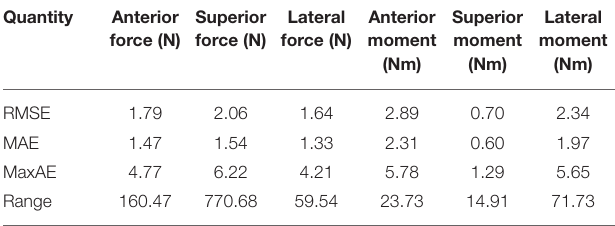
Errors represent the difference between ground reactions measured experimentally and ground reactions calculated by calibrated two-segment foot-ground contact models. Quantities represent averages between the two legs for representative gait cycle.